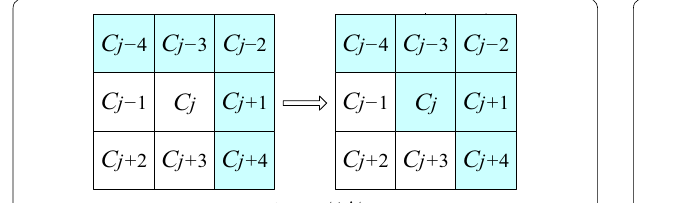
Figure 4 Schematic 3 of the ξ t Cj → ξ t + � t Cj grain boundary